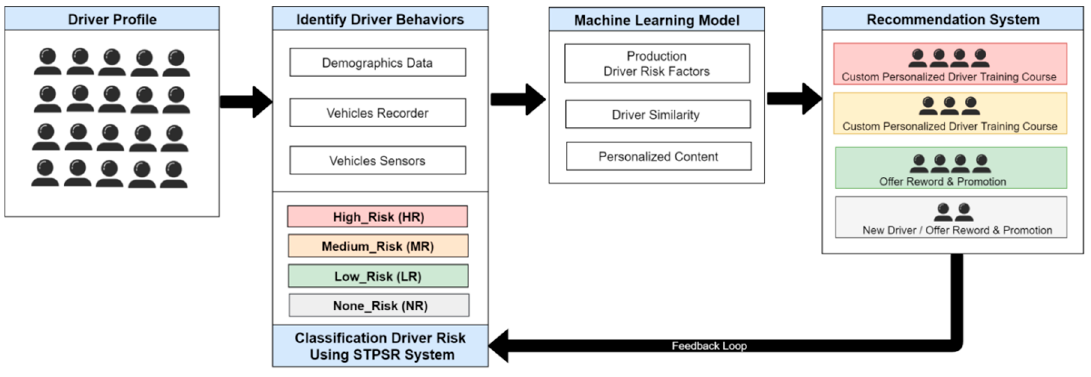
Figure 1. DDP based on hybrid recommendation system